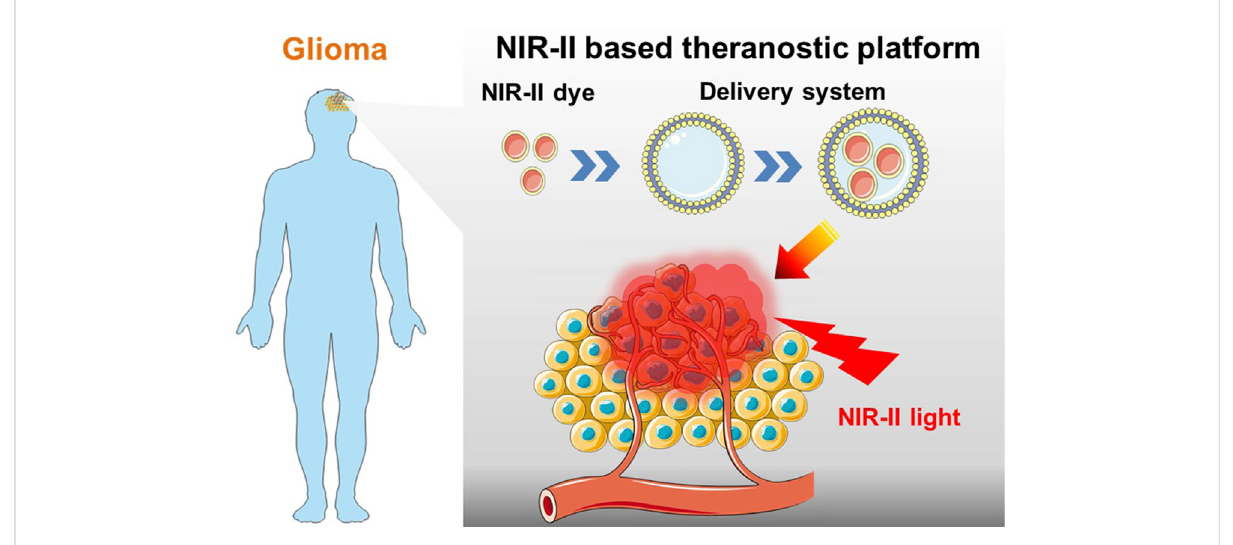
FIGURE 1 Schematic of NIR-II probes equipped with targeted drug delivery nano-platforms for precise diagnosis and effective phototherapy of